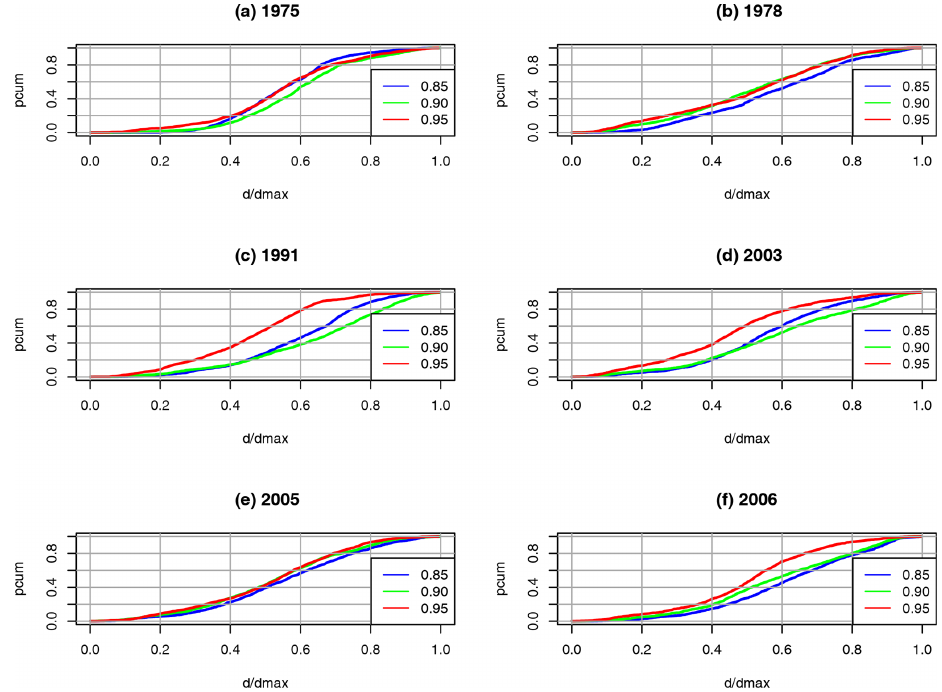
Figure 5. Same as Fig. 2 but for heatwaves in the GE region during JJA. Normal years are 1975, 1991 and 2005 (a, c, e) and extreme years are 1978, 2003 and 2006 (b, d, f) .